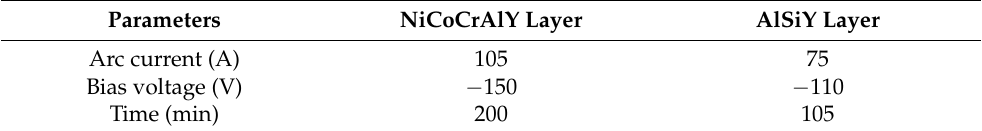
Table 1. Experimental details of all